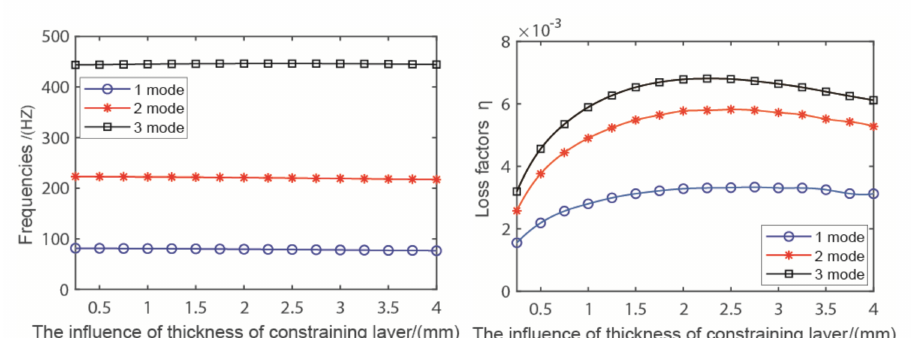
Figure 9. The influence of the thickness of the constraining